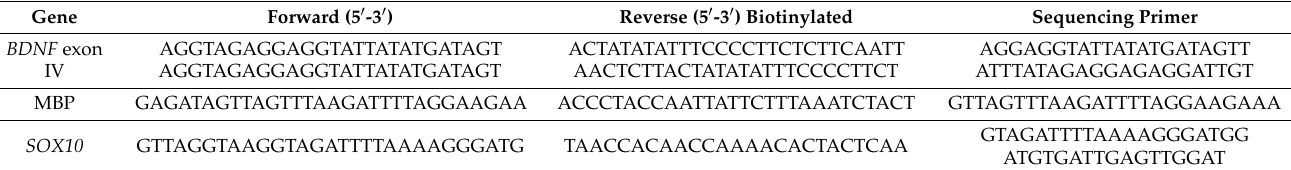
Table 1. Primer set for pyrosequencing.